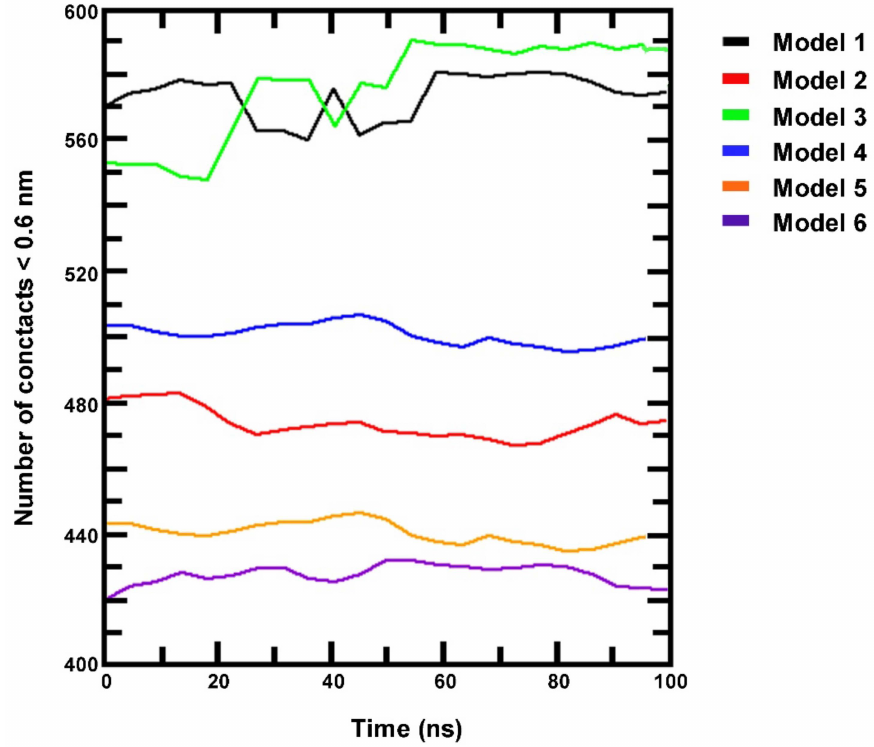
Figure 5. Direct interactions between HIF-1 and the 6 DNA fragments containing the HBSs as extrapolated from 100 ns molecular dynamics trajectory simulation, expressed as number of contacts within 0.6 nm distance between each